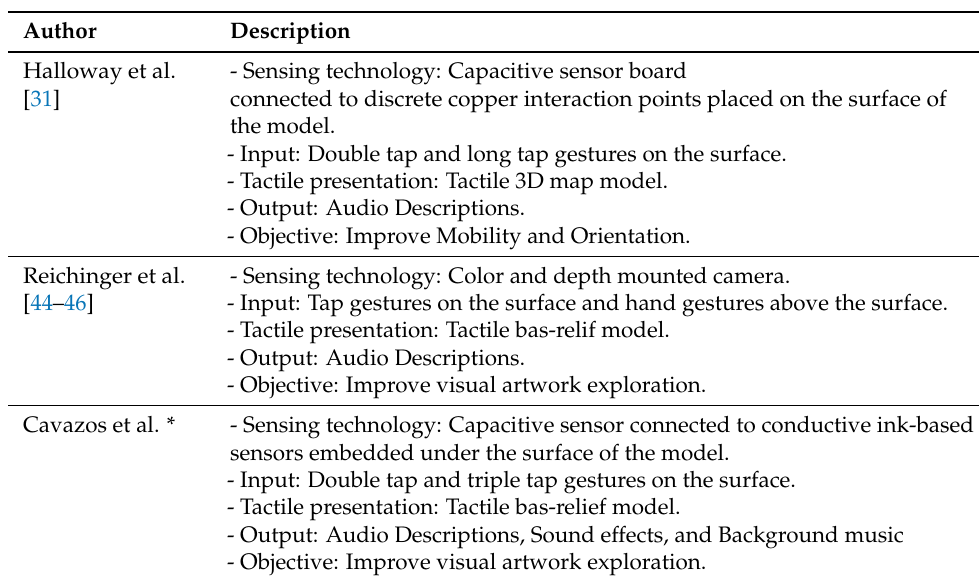
Table 1. Features of the proposed interactive multimodal guide and selected related